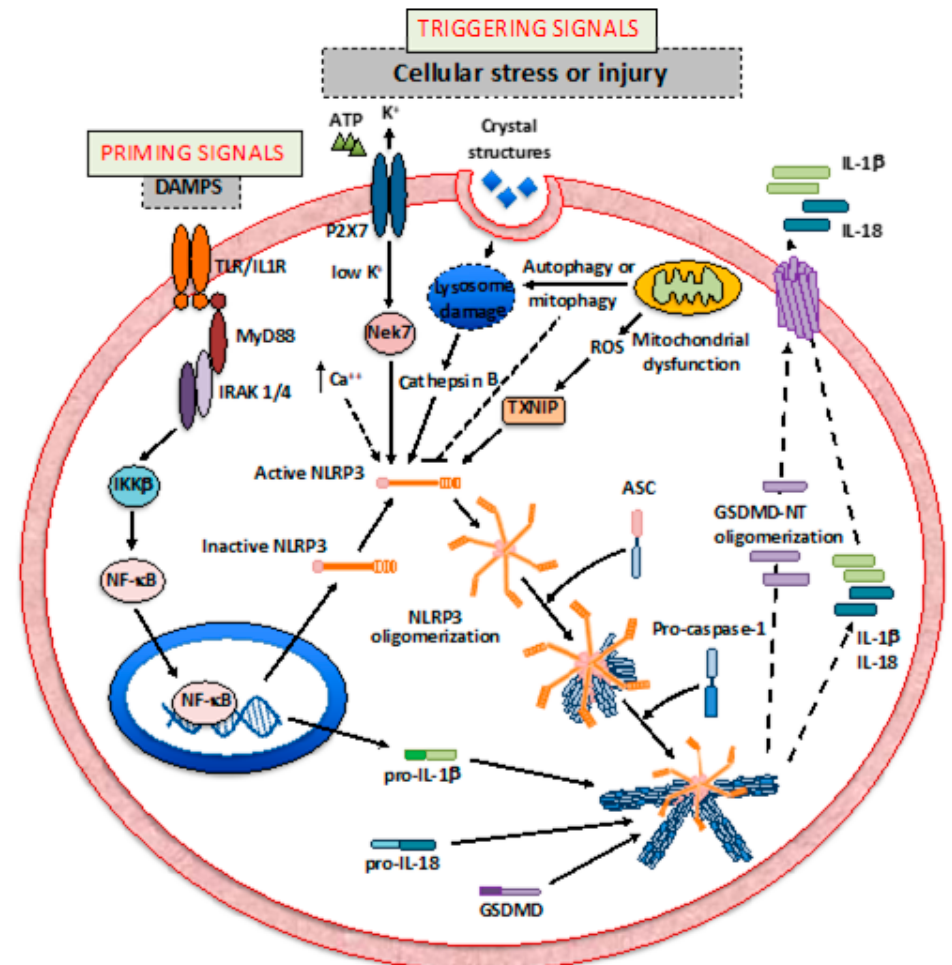
Figure 2. The priming and triggering signals that regulate the inflammasome are initiated by the cellular stressors or by injury. The priming ones regulate transcription of the inflammasome components mainly though nuclear factor kappa B (NF- κ B) activity, while the triggering ones consist of the signal necessary to activate NLRP3, leading to the assembly of the inflammasome; activation of caspase-1; and cleavage of the substrates pro-interleukin (IL)-1 β , pro-IL-18 and Gasdermin D (GSDMD). The N-terminal (NT) fragment of GSDMD forms pores that allow the secretion of active IL-1 β and IL-18. DAMPs, damage-associated molecular patterns; TLRs, Toll-like receptors; IL-1R, interleukin-1 receptor; MyD88, myeloid differentiation factor 88; IRAK1/4, interleukin-1 receptor-associated kinase 1 and 4; IKK β , inhibitor of kappa B kinase β ; NF- κ B, nuclear factor kappa B; NLRs, Nod-like receptors; Nek7, NIMA-related kinase 7; P2X7, Purinergic receptor 2 X 7; ROS, reactive oxygen species; TXNIP, thioredoxin interacting protein; NLRP3, NACHT, leucine-rich repeat (LRR), and pyrin domain (PYD)-containing protein 3; ASC, apoptosis-associated speck-like protein containing a caspase recruitment domain.